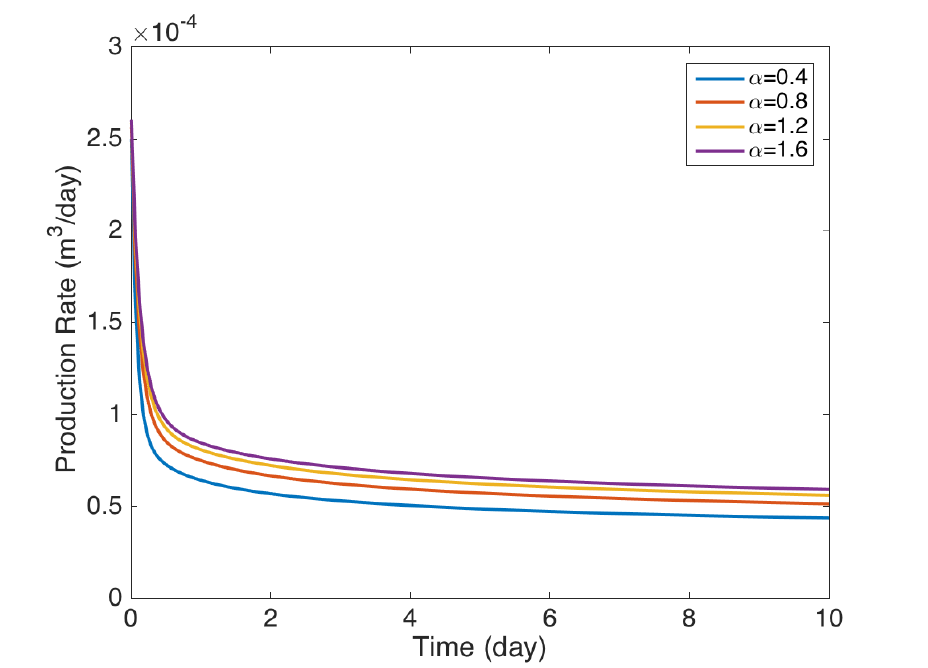
Figure 7. The production rate for various values of α